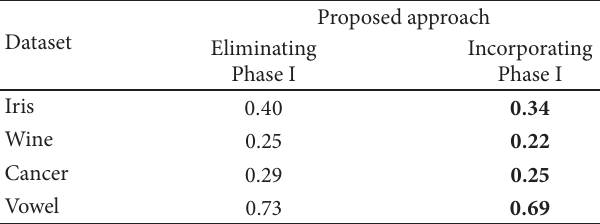
Table 2: Validity of proposed method.